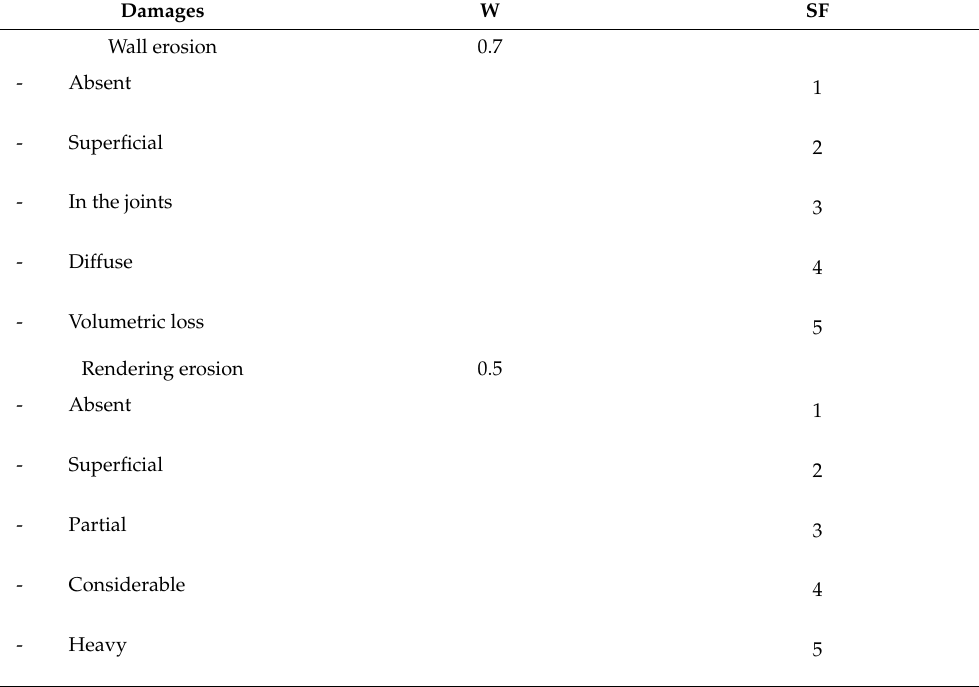
Table 3. Damages susceptibility factors and